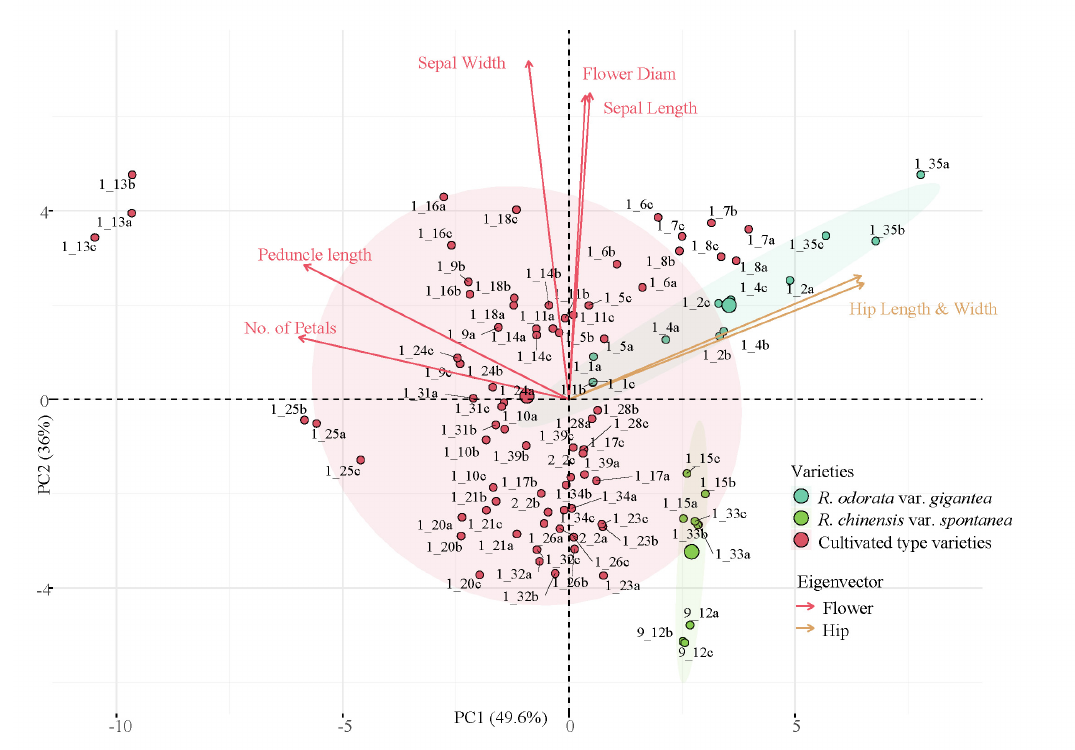
Figure 2. Principal component analysis of R . sect. Chinenses morphological characters. Letters behind the accessions numbers indicate the repeated experiments for each accessions. While the larger point indicate the center of the ellipse.